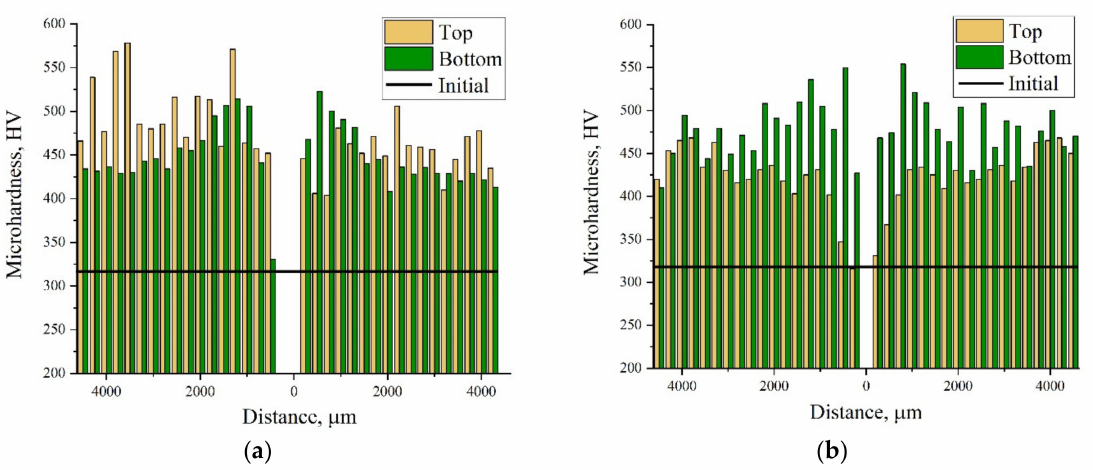
Figure 6. Bar charts of microhardness distribution in segment I: ( a ) ampoule No.1; ( b ) ampoule No. 2.